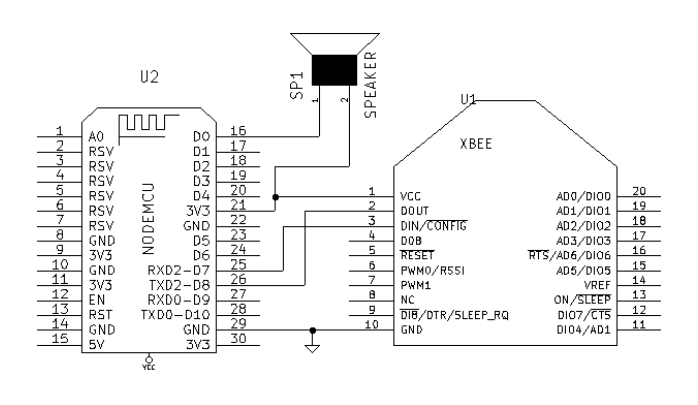
Figure 10. Electronic schematic of the Master